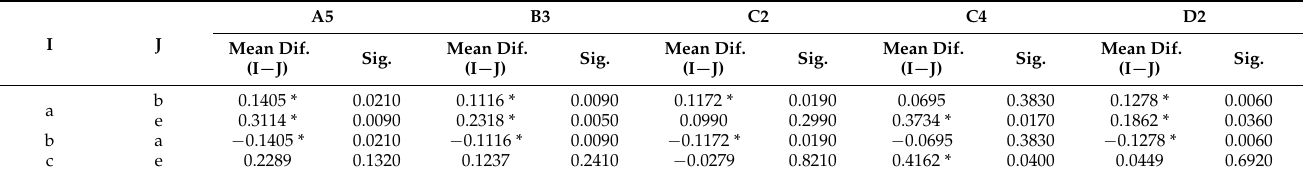
Table 3. Multiple comparison analysis of landscape design indicators of riverside parks beside different river systems (only some important data are displayed here; all data can be found in the Supplementary File in the Supplementary Materials).